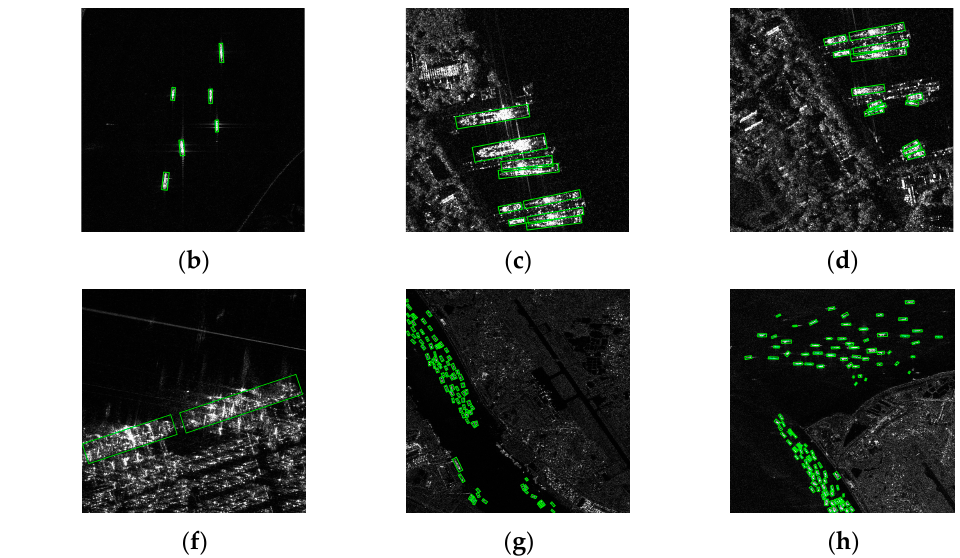
Figure 16. Ship ground truth annotations of diverse SAR images in RSSD. Real ships are accurately marked in green OBBs. ( a ) Offshore single ship; ( b ) offshore multiple ships; ( c , d ) densely arranged ships; ( e ) ships lying off the port; ( f ) ships with large aspect ratios; ( g , h ) small ships in the canal.